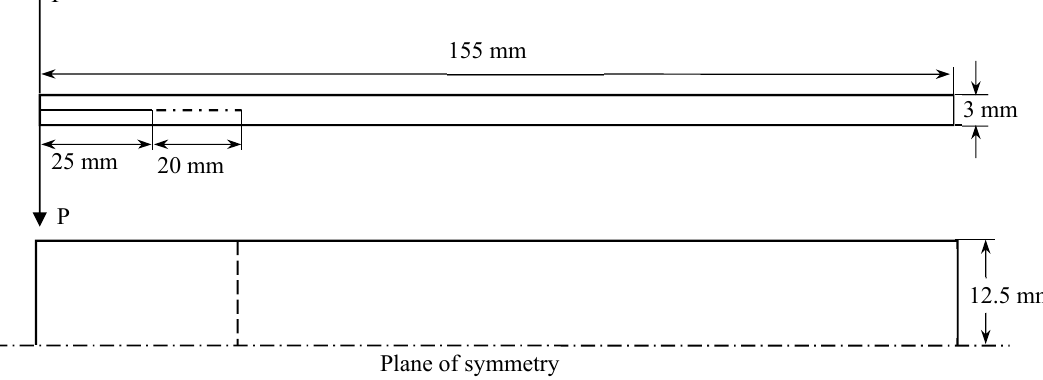
Figure 2. The geometry of double cantilever beam (DCB) specimen in Mode I tests.